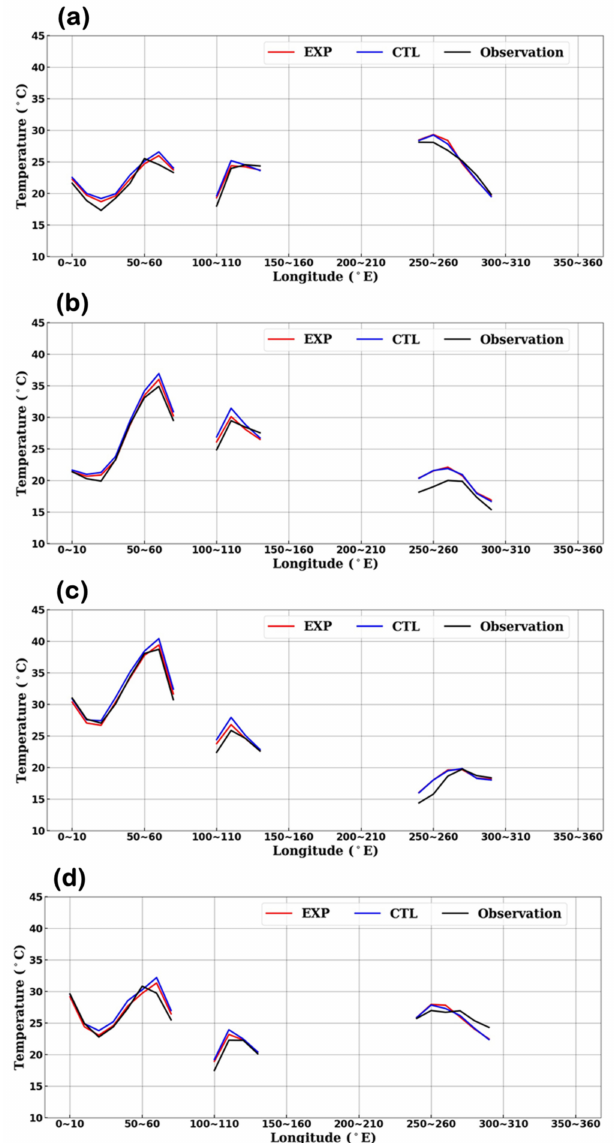
Figure 17. The variations of the near-surface air temperature according to the longitude and latitude from 30 ◦ N to latitude 50 ◦ N in the SYNOP observation and model forecasts (EXP and CTL) at 00 ( a ), 06 ( b ), 12 ( c ), and 18 ( d ) UTC. The 114-h forecasts for 06 and 18 UTC and 120-h forecasts for 00 and 12 UTC were